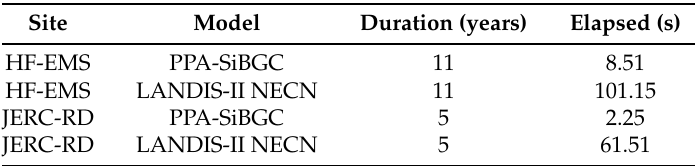
Table 9. Simulation timing